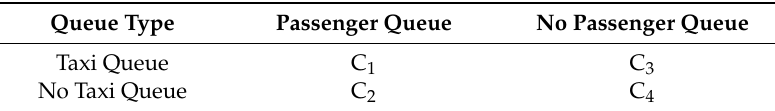
Table 1. Passenger and transportation